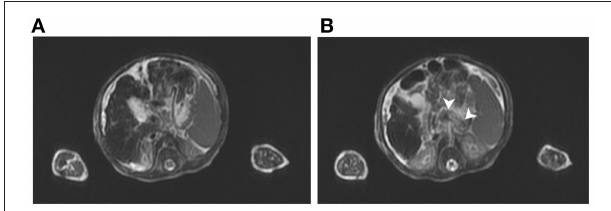
FIGURE 1 | T2-weighted magnetic resonance imaging of case: (A) Siderosis and cirrhosis of liver and (B) metal-induced susceptibility artifact, indicating siderosis of pancreatic body (arrowhead).